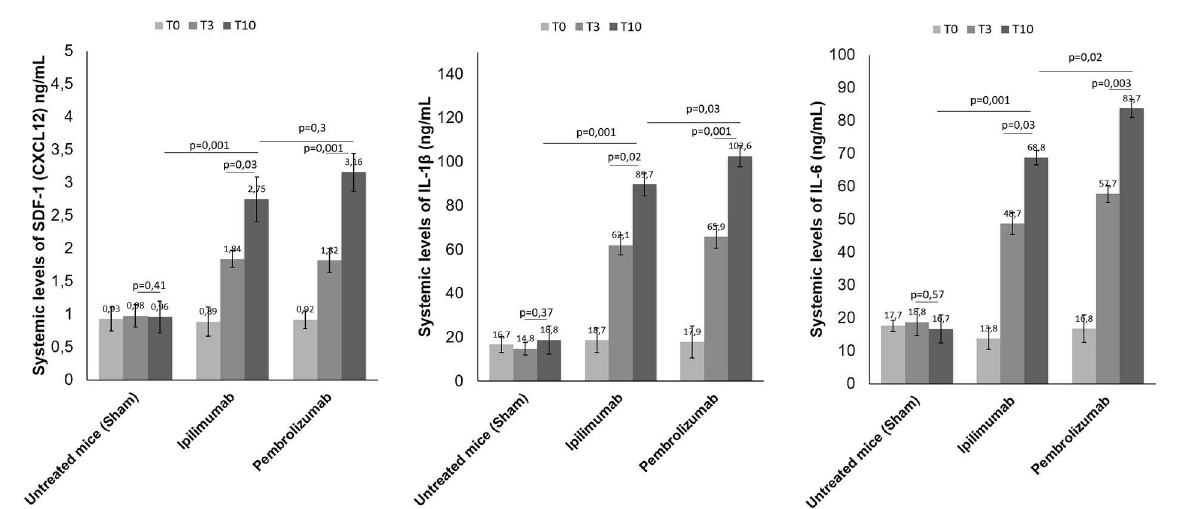
FIGURE7 Effects of ICI treatment on plasma levels of SDF-1 (CXCL-12), Interleukin 1- β and Interleukin-6. Female C57/Bl6 mice were treated daily with anti-CTLA-4 or anti-PD-1 antibodies ( n = 6) or left untreated ( n = 6) for 10 days. Before (T0), after three days (T3) and at the end of treatments (T10), SDF-1 ( n = 6), Interleukin 1- β ( n = 6) and Interleukin-6 ( n = 6) were quantified in plasma. Levels were reported in ng/ml of